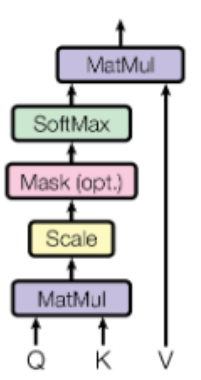
Figure 6. Scaled-Dot Product Attention [24].